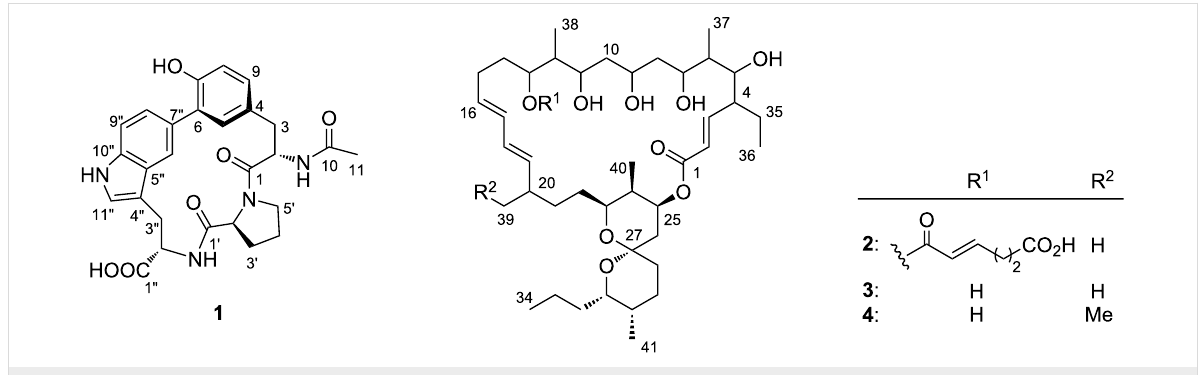
Figure 1: Structures of pseudosporamide ( 1 ) and pseudosporamicins A–C ( 2 – 4